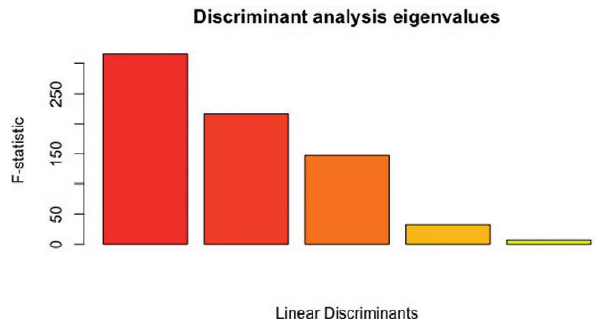
Figure 3. LDA. analysis of. SCoT data in Punica genotypes, show- ing. the first five LDA axes as discriminating factors among them.